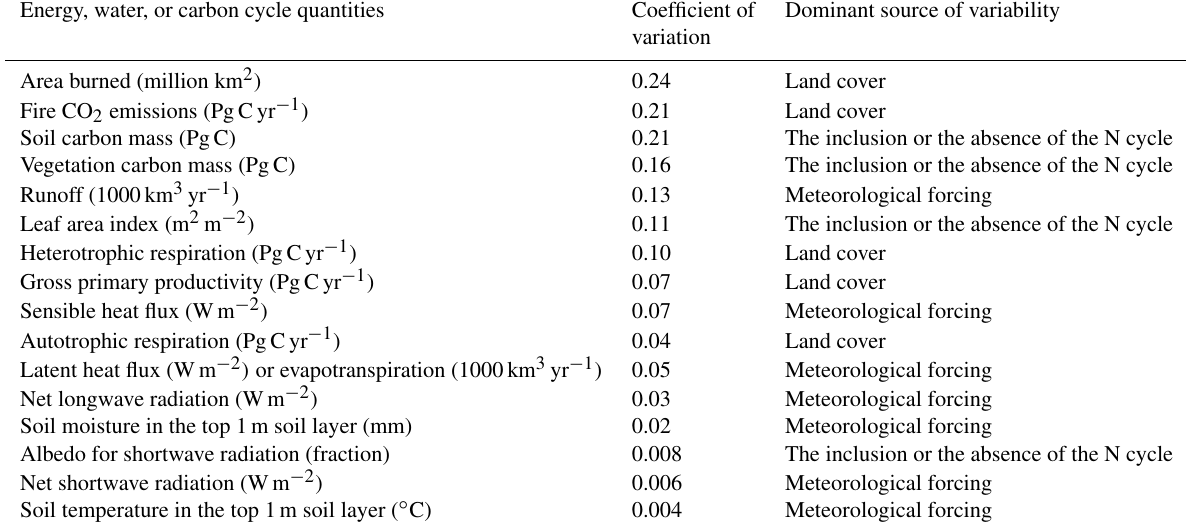
Table 3. Simulated energy, water, and carbon cycle quantities considered in this study sorted according to their coefficient of variation. The quantities are listed from the most variable at the top to the least variable at the bottom. The coefficient of variation is based on annual values averaged over the 1997–2016 period across the eight simulations. The last column shows the dominant source of variability for each model-simulated